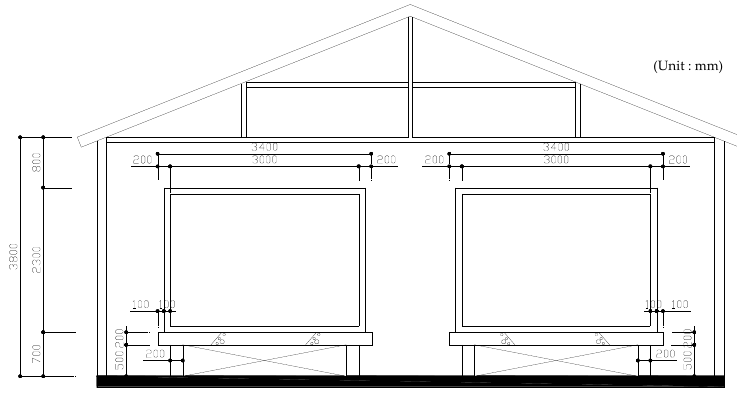
Figure 4. Design drawings of heat storage experiment.